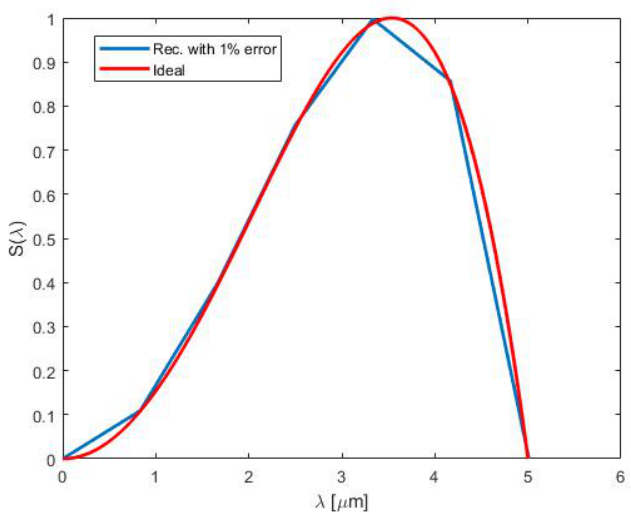
Figure A6. Reconstruction of the spectral response function with Hermite polynomials compared to the 1% voltage error case.